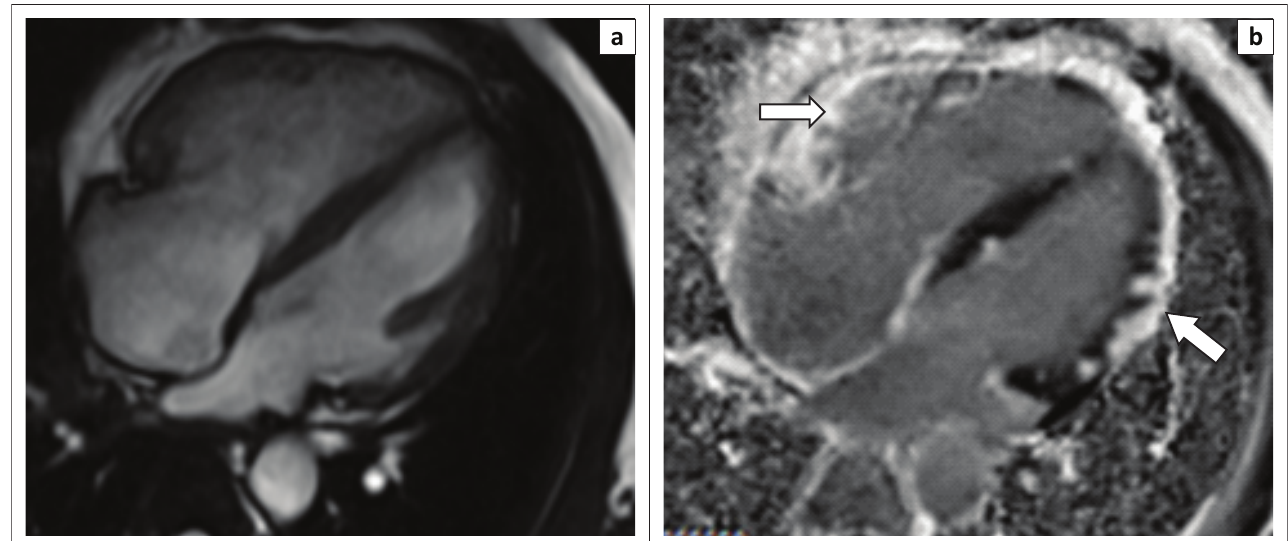
FIGURE 8: Sarcoidosis. End-diastole four-chamber cine b-SSFP image (left) demonstrates increased RV size. The four-chamber late gadolinium PSIR image (right) demonstrates prominent RV free wall enhancement (smaller arrow) as well as nodular enhancement of the septum and LV lateral wall (larger